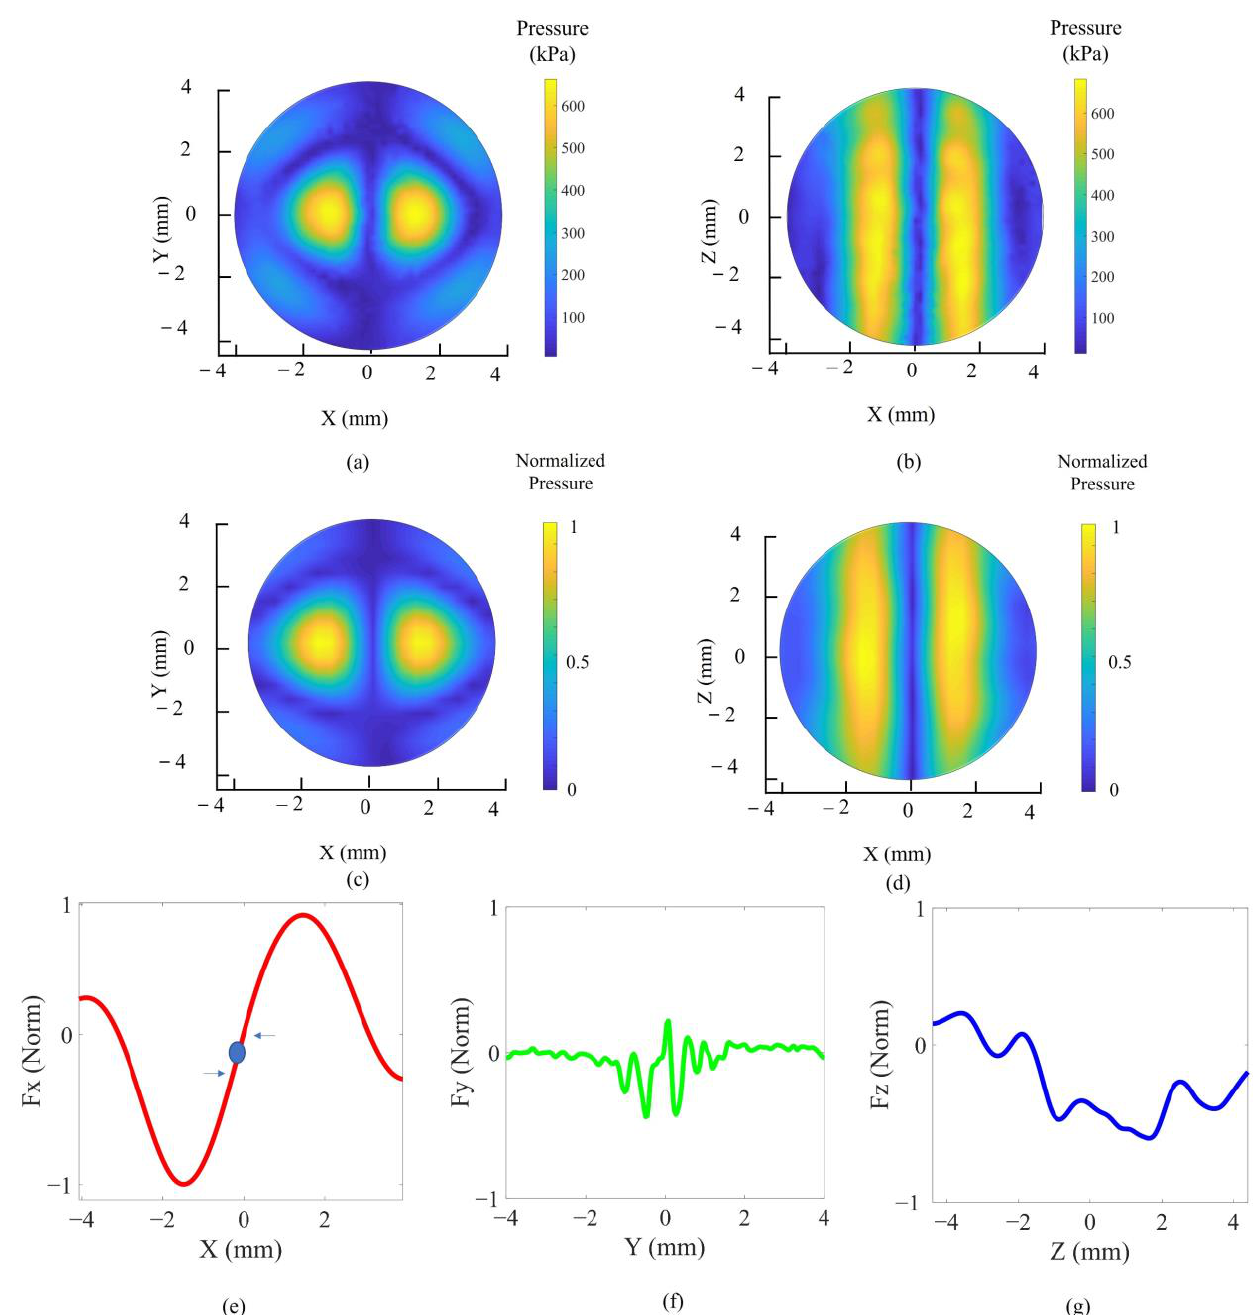
Figure 7. The 3D scanned pressure field for the generated twin trap with PRCM: ( a ) the O-XY plane view; ( b ) the O-XZ plane view; ( c ) the twin trap simulation result in the O-XY plane; ( d ) in the O-XZ plane; the simulation of acoustic radiation force normalization in the ( e ) X axis; ( f ) Y axis; ( g ) Z axis. phase information ranging from − π to π radians at 20 Vpp bipolar voltage with the same amplitude. The trap point was located at (0, − 0.2, 0.4), and the maximum